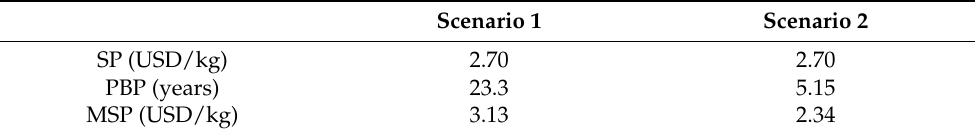
Table 5. Selling price (SP), payback period (PBP) and MSP of Scenario 1 and 2.